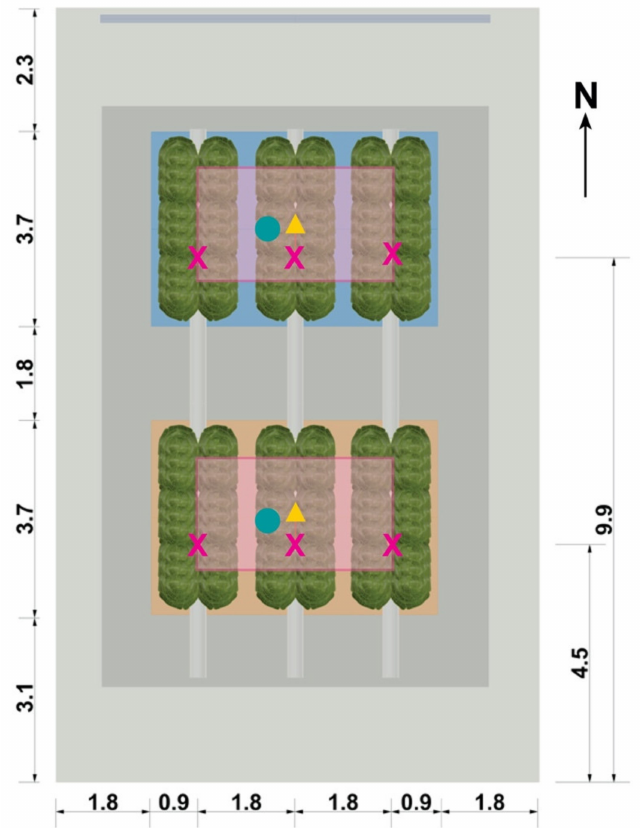
Figure 3. Top view of greenhouse growing area layout, with the OPV and Control planting sections highlighted in blue and orange rectangles (each 17.3 m 2 ), respectively. The pink rectangles represent the sampling region in each section. The positions of solar radiation sensors (red ‘X’), relative humidity/air temperature sensors (blue circle), and infrared radiometers (yellow triangle) are shown. Dimensions are in